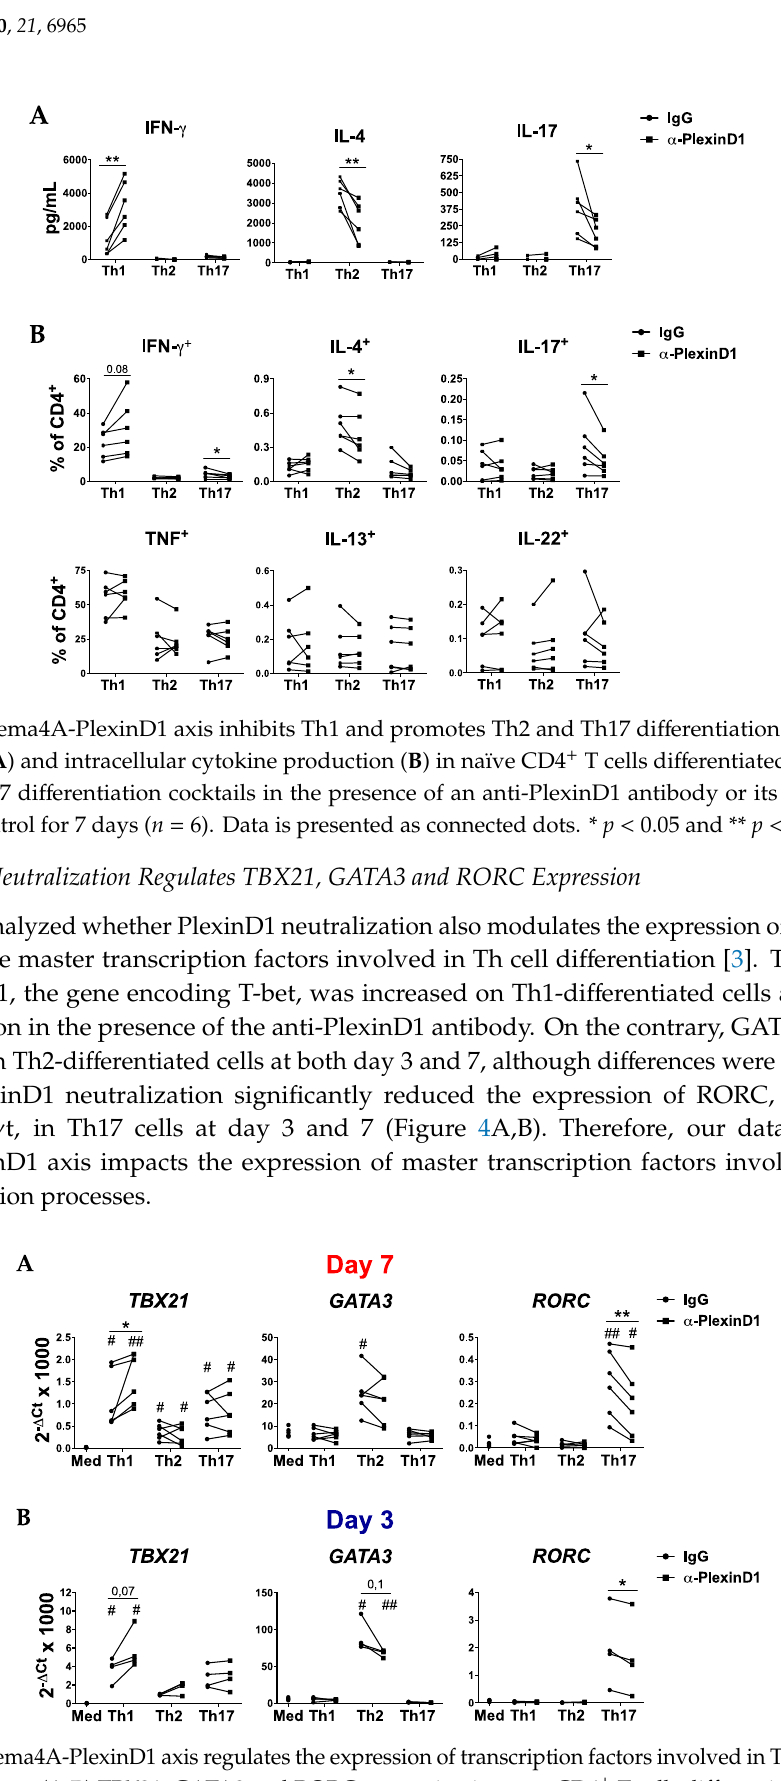
Figure 4. Sema4A-PlexinD1 axis regulates the expression of transcription factors involved in T helper cell differentiation. ( A,B ) TBX21, GATA3 and RORC expression in naïve CD4 + T cells differentiated either in medium or Th1, Th2 or Th17 differentiation cocktails in the presence of an anti-PlexinD1 antibody or its respective isotype control for 7 days ( A , n = 6) and 3 days ( B , n = 4). Data is presented as connected dots. * p < 0.05 and ** p < 0.01. # p < 0.05 and ## p < 0.01 compared to the